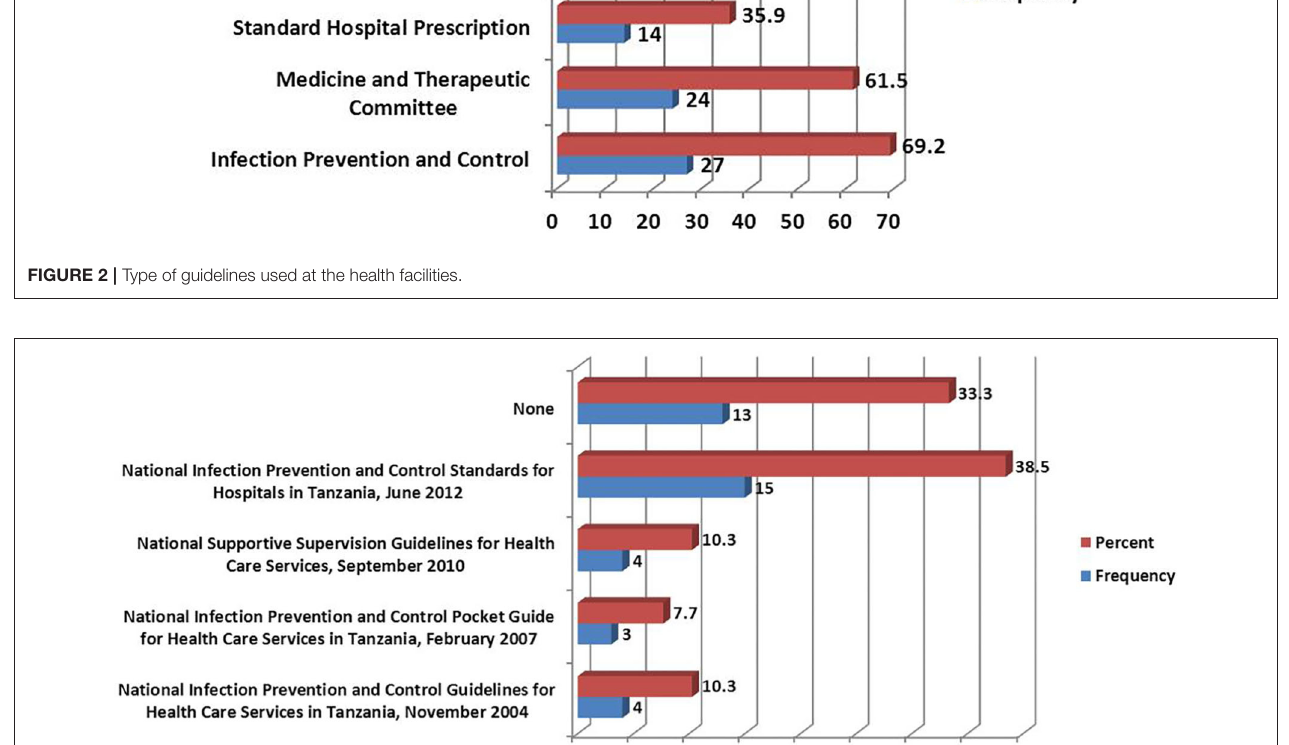
FIGURE 3 | Versions of infection prevention and control guidelines used at the health facilities.